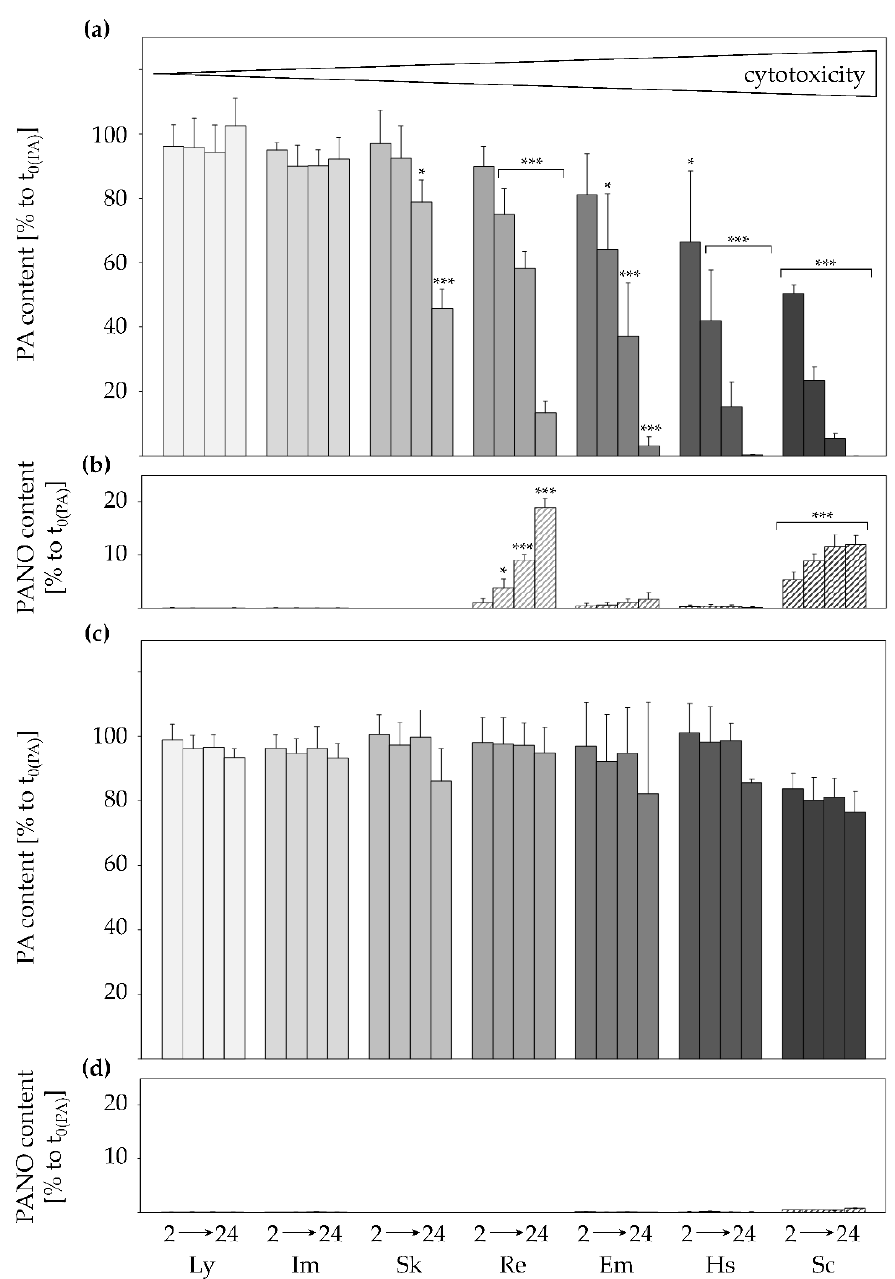
Figure 2. Time-dependent reduction of seven structurally different PAs in cell culture medium of differentiated HepaRG cells under different temperatures of 37 ◦ C ( a , b ) and 4 ◦ C ( c , d ). HepaRG cells were incubated for 2, 4, 8, and 24 h with 700 nM of lycopsamine, intermedine, senkirkine, retrorsine, echimidine, heliosupine, or senecionine, respectively. Cell culture medium was collected after each time point and PA content (gray bars) and PANO content (striped bars) measured by LC-MS/MS. PA and PANO content is given in percent of the initial concentration of respective PA (at t 0 ) as mean + SD of three to four independent experiments with two incubations each. Please note the unequal scaling of the different y-axes. Cytotoxicity grading was done using data from Glück et al. (2021) [41]. For raw data presentation in ng/mL please see Figure S1 (in the Supplementary Materials). Statistical analysis was performed using one-way ANOVA, followed by Dunnett’s post-hoc test, and significant differences are depicted as follows: * for PA and PANO content with * p < 0.05, *** p < 0.001. Ly, lycopsamine; Im, intermedine; Sk, senkirkine; Re, retrorsine; Em, echimidine; Hs, heliosupine; Sc, senecionine.